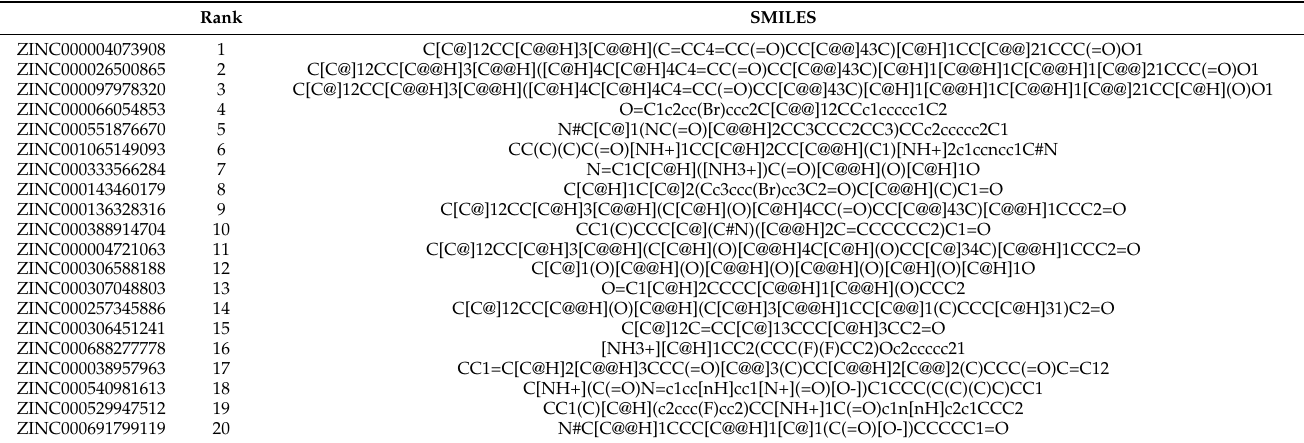
Table 2. SMILES for the compounds in Table